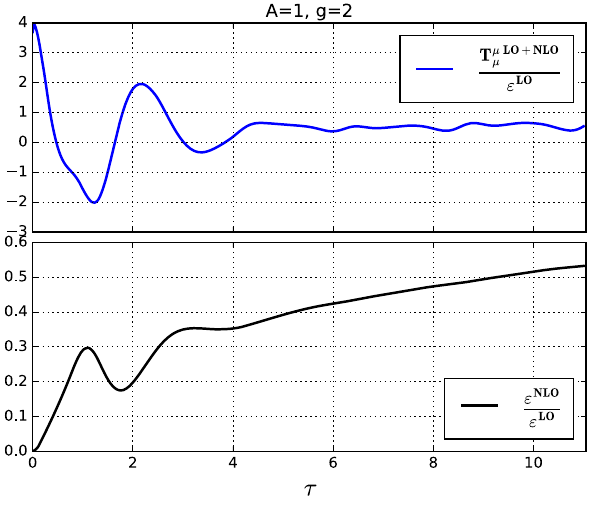
Fig. 1 Top panel: the trace of the energy-momentum tensor Eq. (54) normalised by LO energy density; bottom panel: the ration of the NLO energy density and the LO energy density. All values are averaged over the ensemble of the initial condition with the Wigner function of Eq. (22). Parameters of the averaging are following: A =10, α 0 =1, p 0 =1, g =2